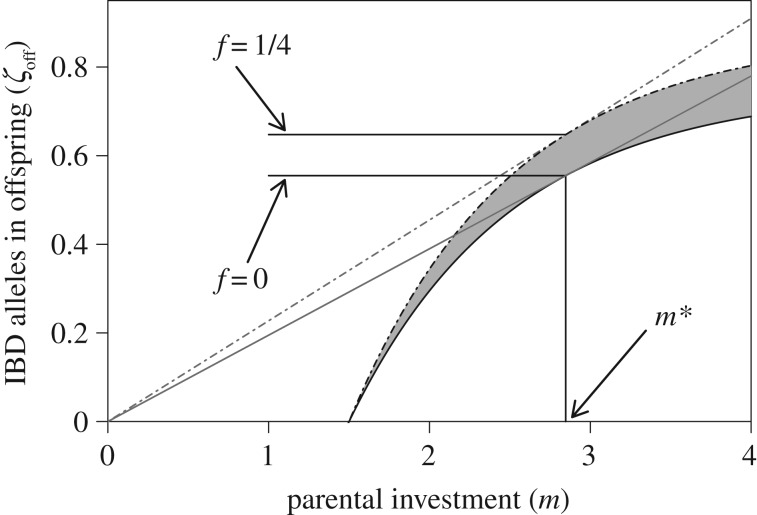
Relationship between parental investment (m) and the number of identical-by-descent (IBD) copies of a focal female's alleles that are present in its viable offspring (ζoff) for females that are outbred (f = 0; solid lower curve) versus females that are inbred (f = 1/4; dotted-dashed upper curve). Grey shading between the curves shows the difference in ζoff between outbred and inbred females across different degrees of parental investment. Thin grey tangent lines for each curve identify optimal parental investment (m*).